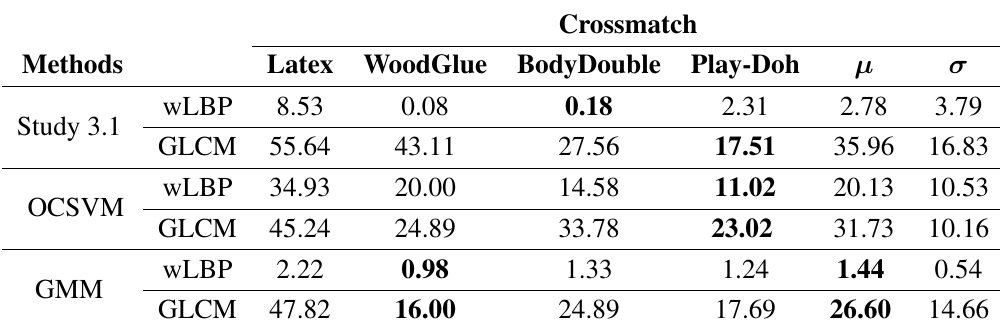
Table 10. ACER for the CrossMatch dataset, study 3 (ACER in % ).